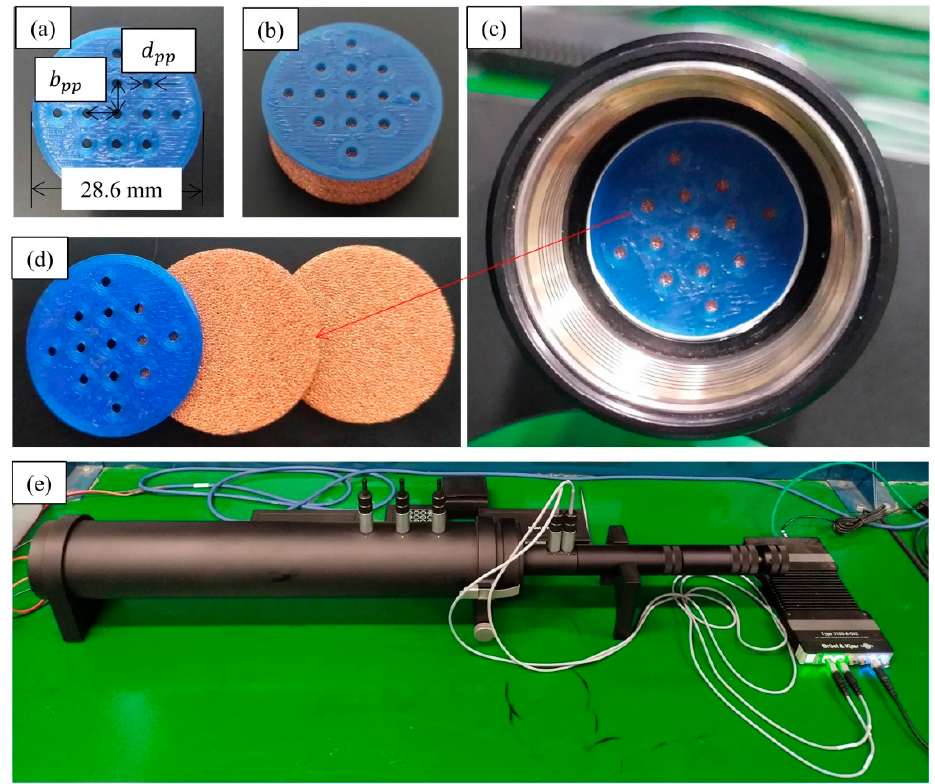
Figure 6. The prepared test specimens and the impedance tube: ( a ) 3D printed PP sample; ( b ) PP1 + OFC2; ( c ) test specimen mounted in the impedance tube; ( d ) the placement order of PP1 + OFC2; ( e ) the B and K impedance tube.